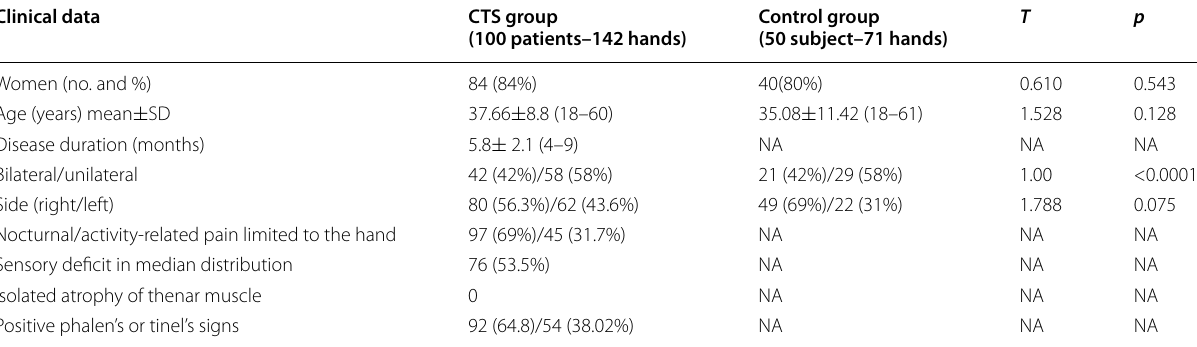
*P is significant at